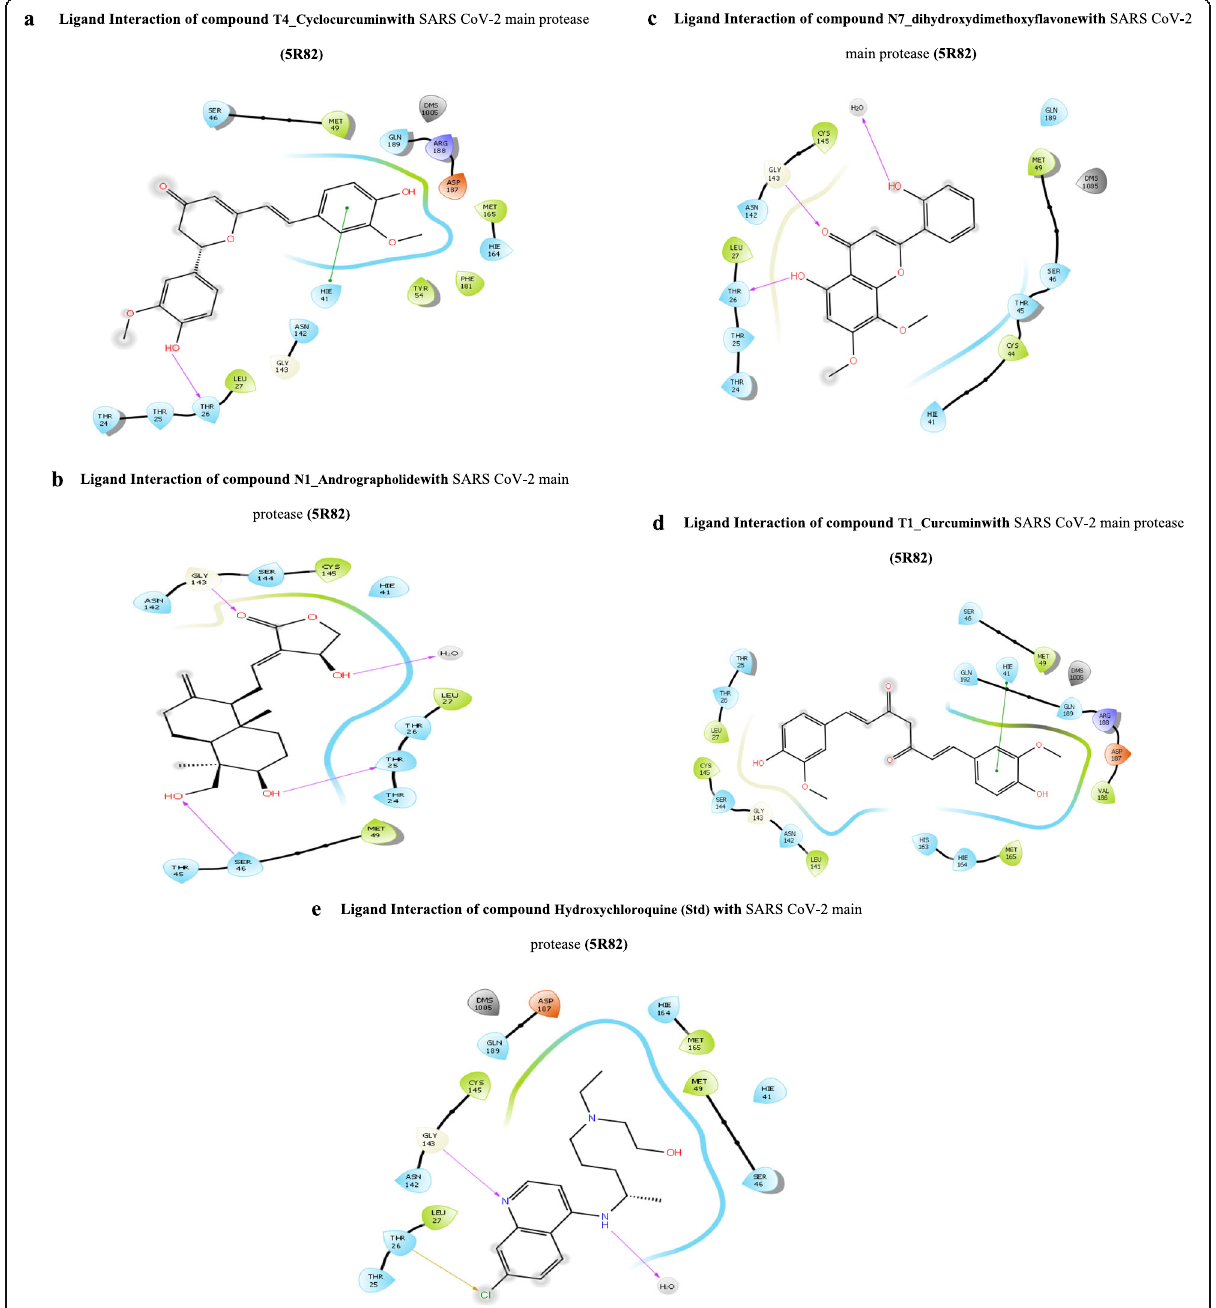
Fig. 3 a Ligand interaction of compound T4_Cyclocurcuminwith SARS CoV-2 main protease (5R82). b Ligand interaction of compound N1_Andrographolidewith SARS CoV-2 main protease (5R82). c Ligand interaction of compound N7_dihydroxydimethoxyflavonewith SARS CoV-2 main protease (5R82). d Ligand interaction of compound T1_Curcumin with SARS CoV-2 main protease (5R82). e Ligand interaction of compound hydroxychloroquine (Std) with SARS CoV-2 main protease